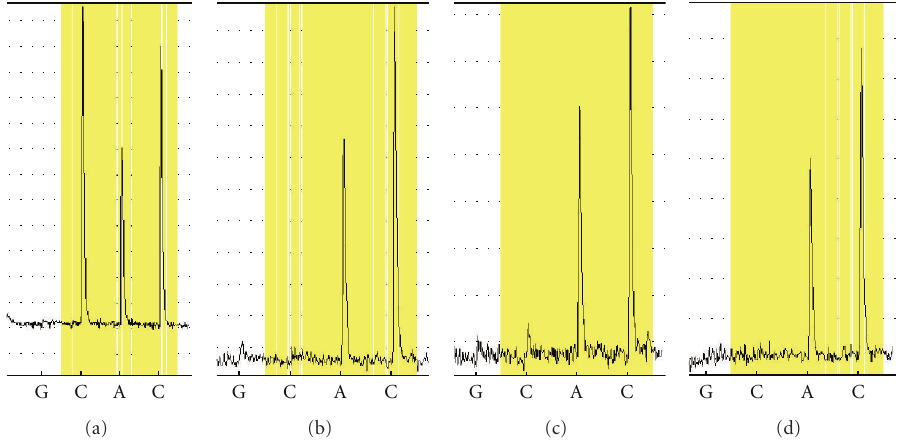
Figure 4: Pyrosequencing results (a) 38.9% C and 61.1% A at the mutational point of the patient. (b)–(d) 100.0% A and 0.0% C at the corresponding point of his parents and